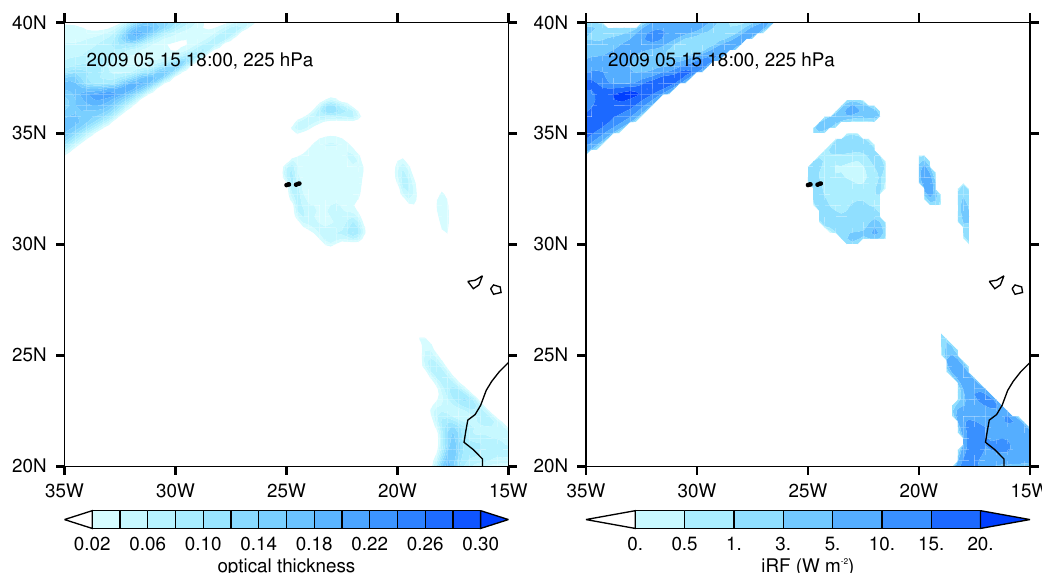
Figure 6. ( Left ): Field of potential contrail optical thickness and ( Right ): Field of potential instantaneous radiative forcing for the situation of Figure